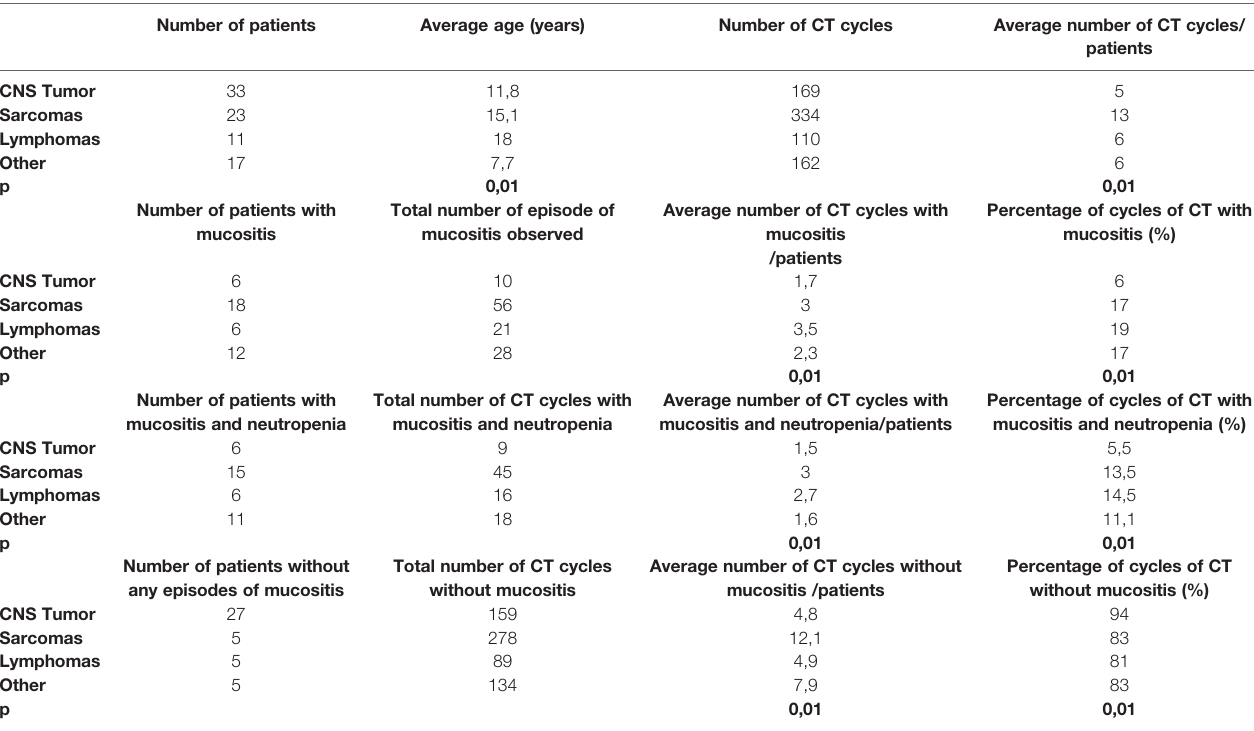
TABLE 2 | Characteristics of the children strati fi ed by tumor ’ s